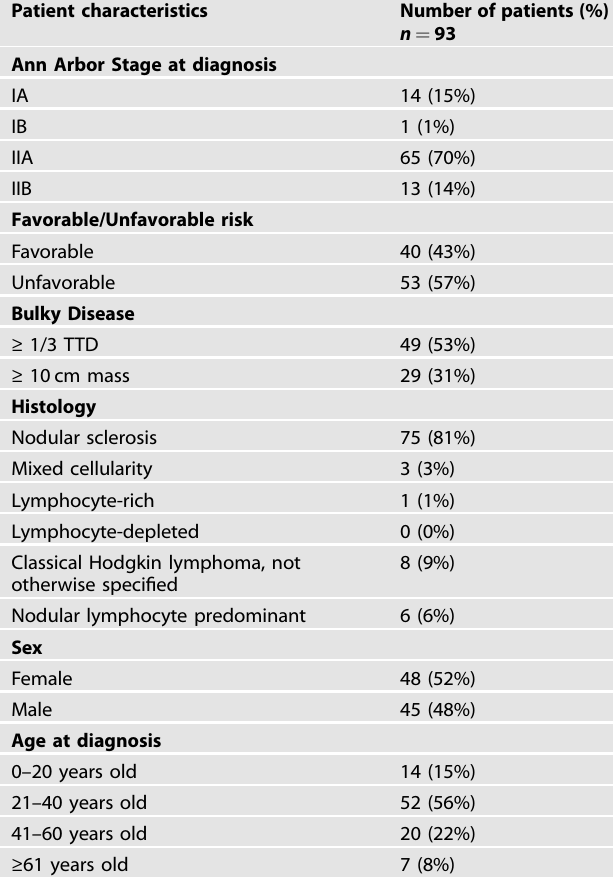
Table 1. Patient characteristics.